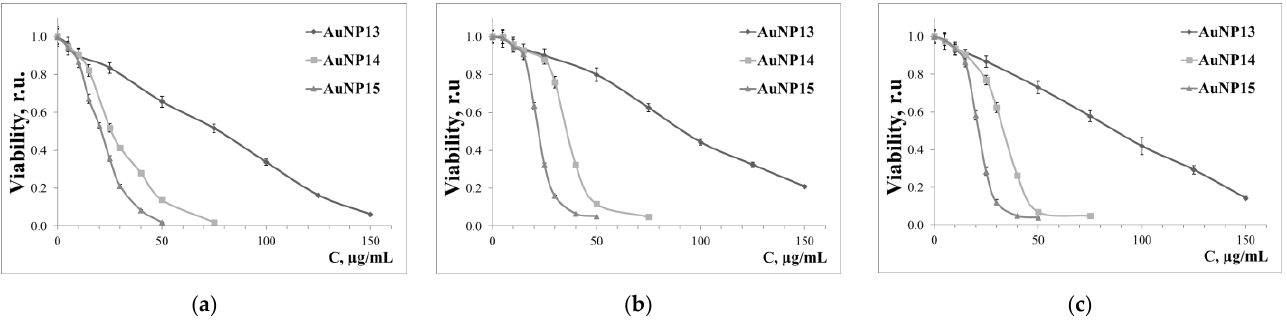
Table 3. Half maximal inhibitory concentration (IC50) for the studied cell lines.